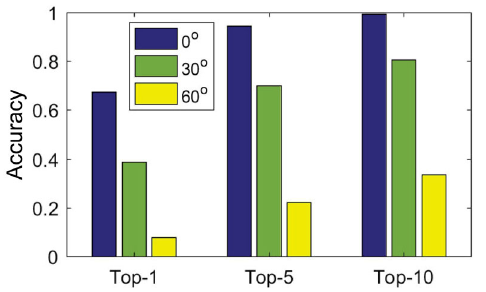
Fig. 7 Labeling accuracies for facial trajectories on OuluVS2 of different camera views including 0 ◦ , 30 ◦ , and 60 ◦ .